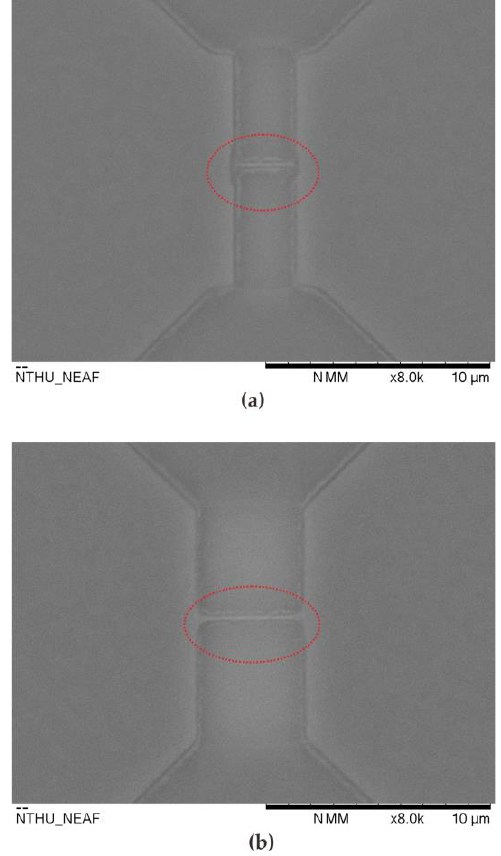
Figure 12. Top-view SEM images of the proposed sensor after 40 applications. ( a ) doped type nanowire sensors with lengths of 3.5 μ m; ( b ) doped type nanowire sensors with lengths of 5.3 μ m.